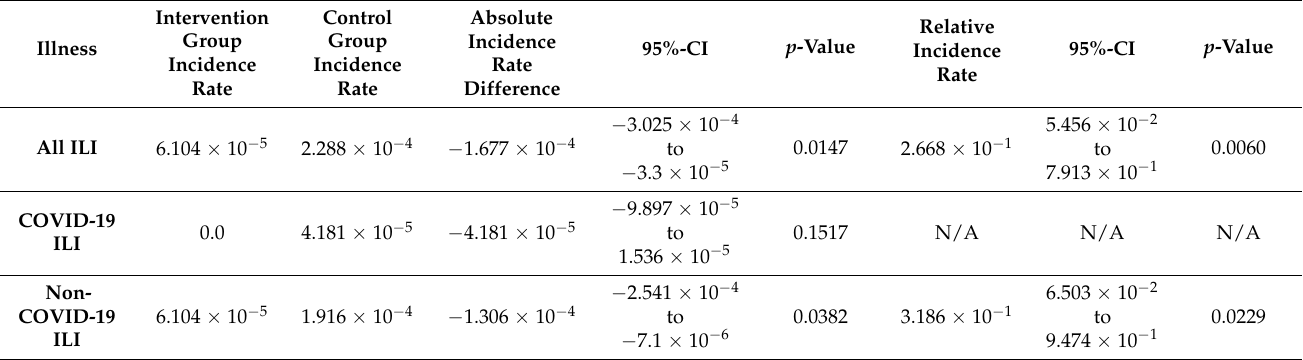
Table 3. Primary and secondary outcomes.